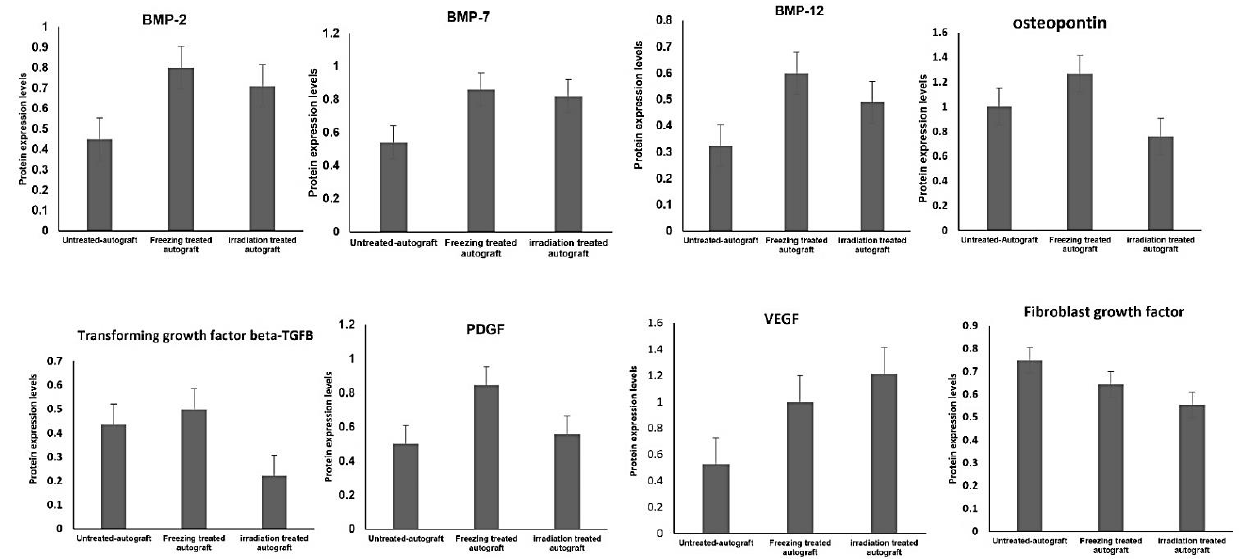
Figure 6. Protein abundance difference of the identified BMPs and growth factor proteins from the mass spectrometry analysis.